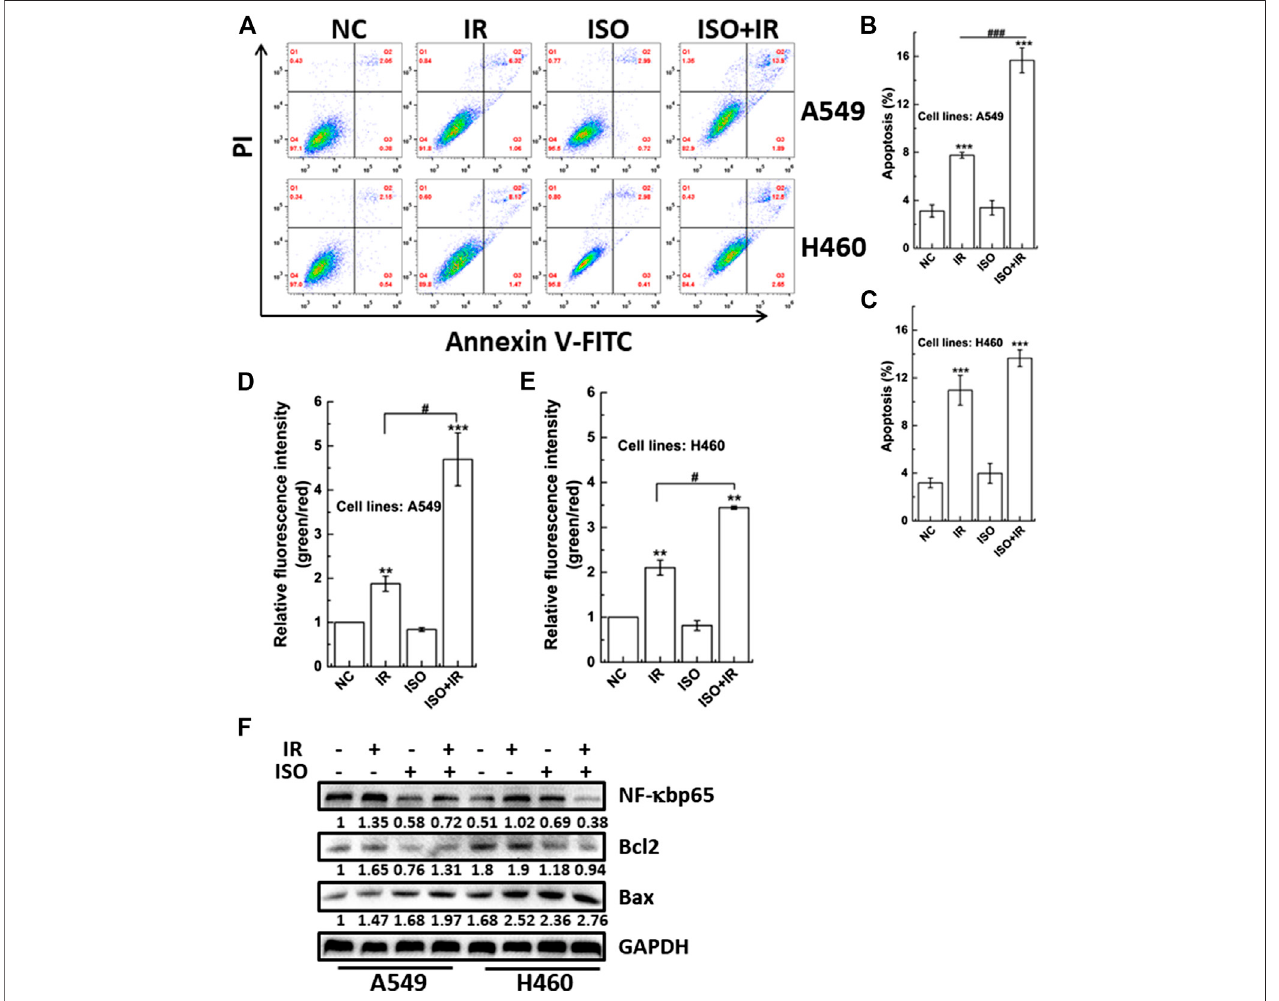
FIGURE 3 | The impact of ISO combined irradiation on cell apoptosis and the MMP. The levels of apoptosis in A549 (A , B) and H460 (A , C) cells pretreated with/without ISO and then exposed to 2 Gy X-rays irradiation. The irradiated cells were sequentially cultured for 48 h and then harvested to be analyzed by an Annexin V/PI fl ow cytometry analysis. The MMP was quanti fi ed by the microplate reader in A549 (D) and H460 (E) cells pretreated with/without ISO and followed by 2 Gy X-rays at24 hafterirradiation. (F) Theexpressionlevelsofapoptosis-relatedproteinswereassessedandquanti fi edbywesternblottinginA549andH460cells.Cellswere pretreated with/without ISO for 24 h and followed by 0 or 2 Gy X-rays and then analyzed by western blot after 12 h. *** p < 0.001 vs. the control group. ### p < 0.001 vs. non-drug-treated cells.